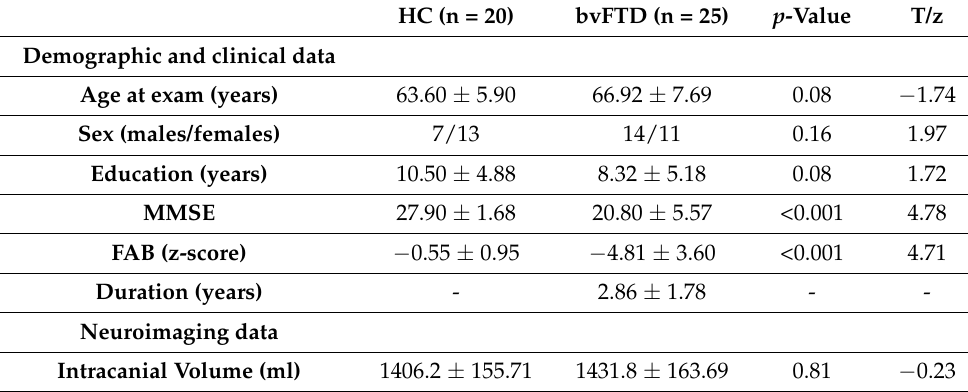
Table 1. Demographic, clinical, and neuroimaging data of sample.